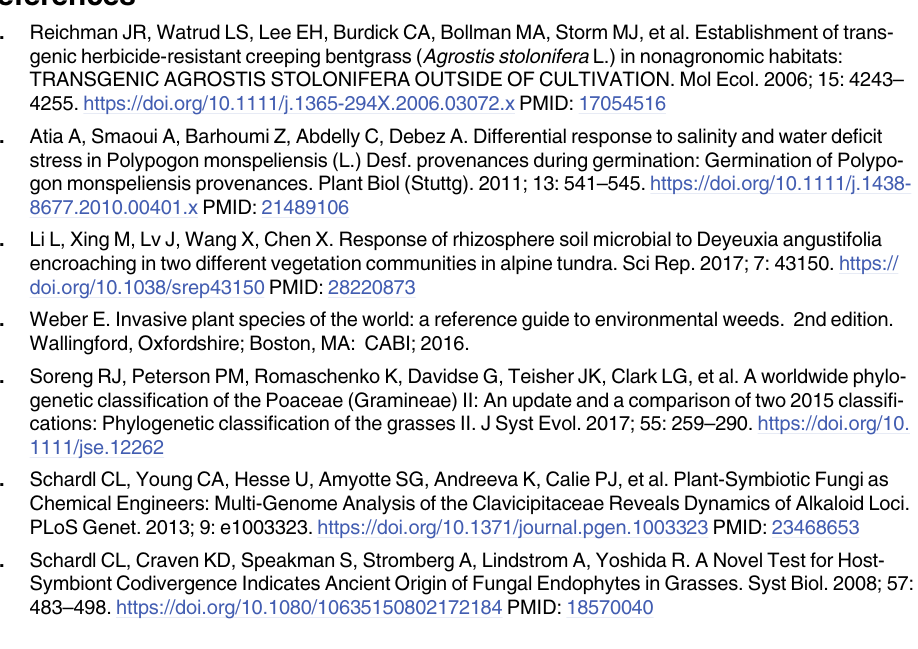
S5 Table. Short-read sequencing-based gene expression analysis. Read count quantification was preformed using the NCBI BLAST tool. The word size parameter was set at 64. The As BGNL and As FMOL sequences were used as query